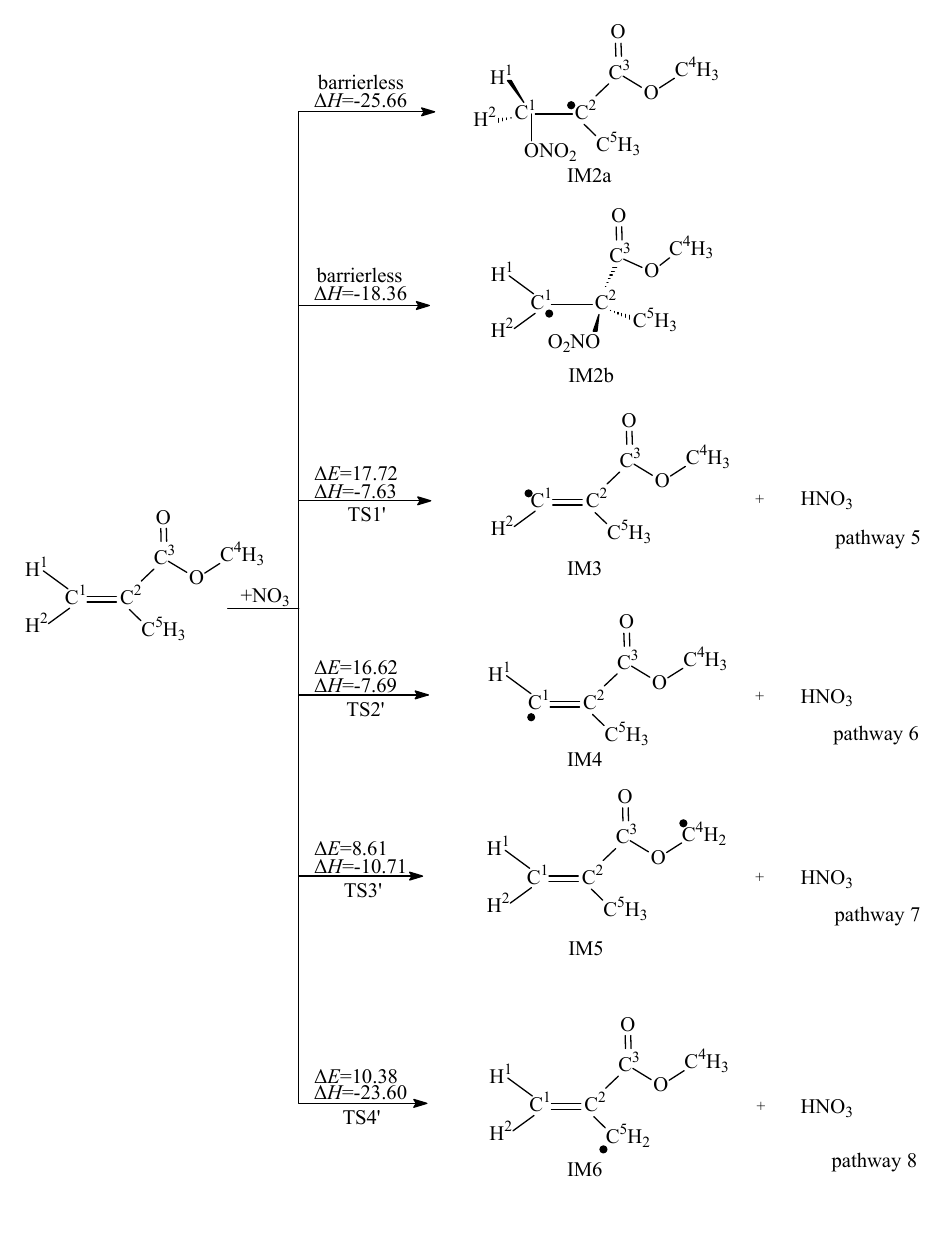
radical-initiated reaction schemes embedded with the potential barriers Δ E Figure 2. NO 3 (in kcal/mol) and reaction heats Δ H (in kcal/mol, 0